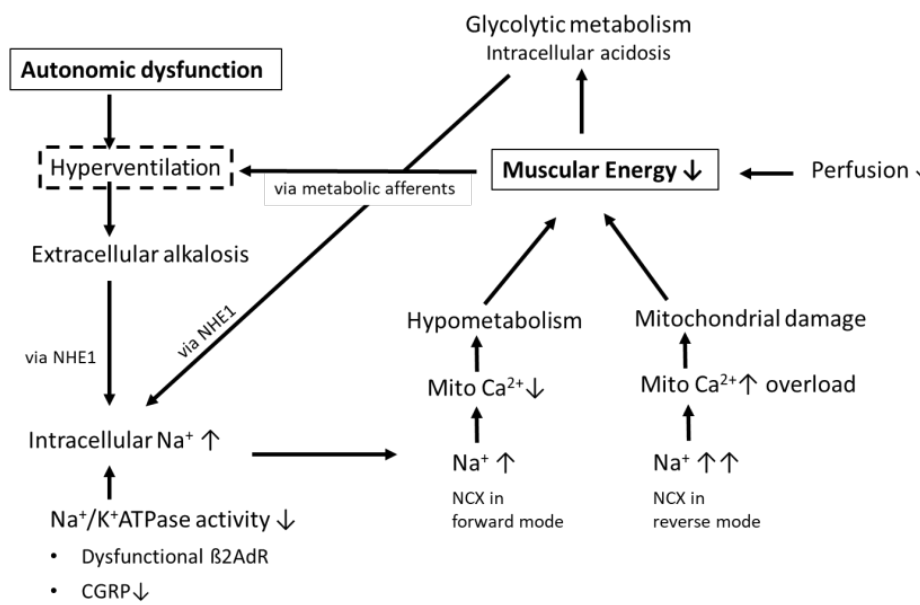
Figure 1. Pathophysiological changes in skeletal muscles related to exercise-induced hyperventila- tion in PCS.